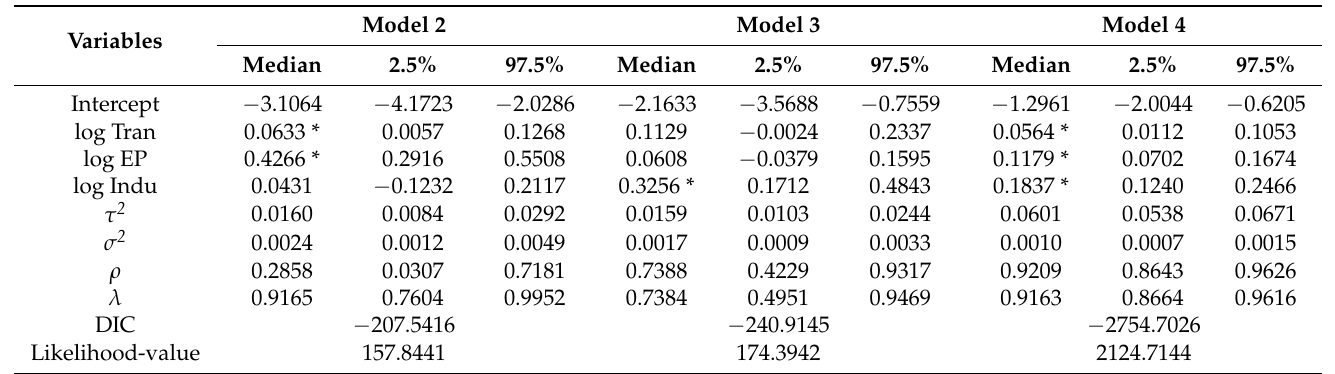
Table 3. Model 2, 3 and 4 estimation